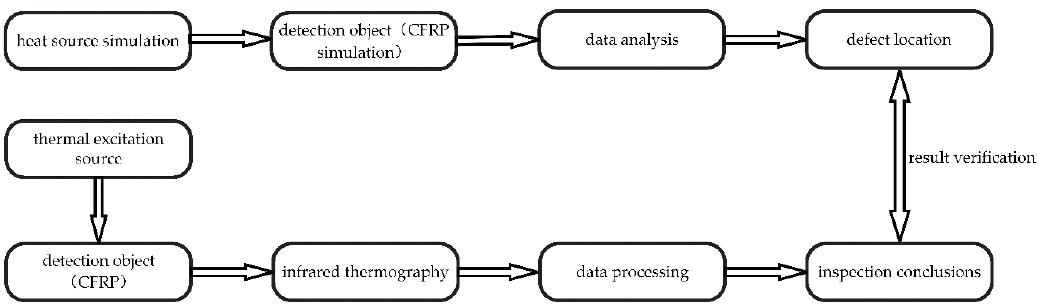
Figure 4. Block diagram of experimental steps.